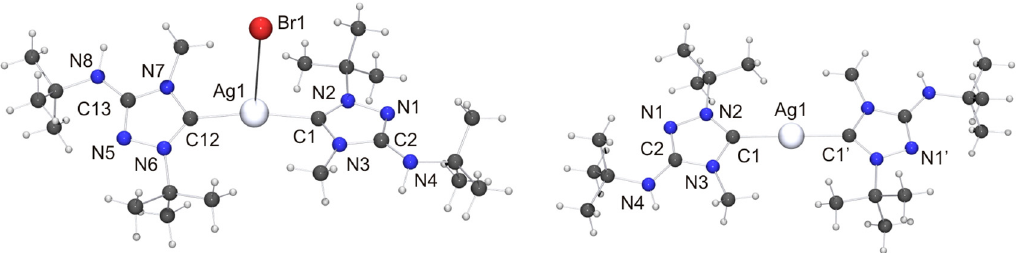
Figure 10. ( Left ) Molecular structure of [AgBr( 6 ′ ) 2 ]·toluene in the crystal. The solvent molecule has been omitted for clarity. Selected bond lengths [Å] and angles [°]: C1 ‒ Ag1 2.107(7), C1 ‒ N2 1.327(9),